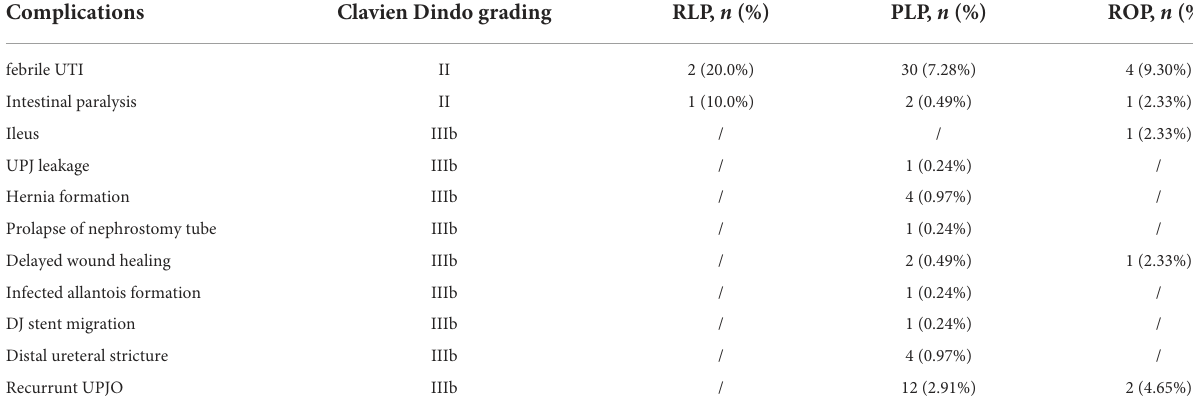
TABLE 1 Complications after primary and redo pyeloplasty.